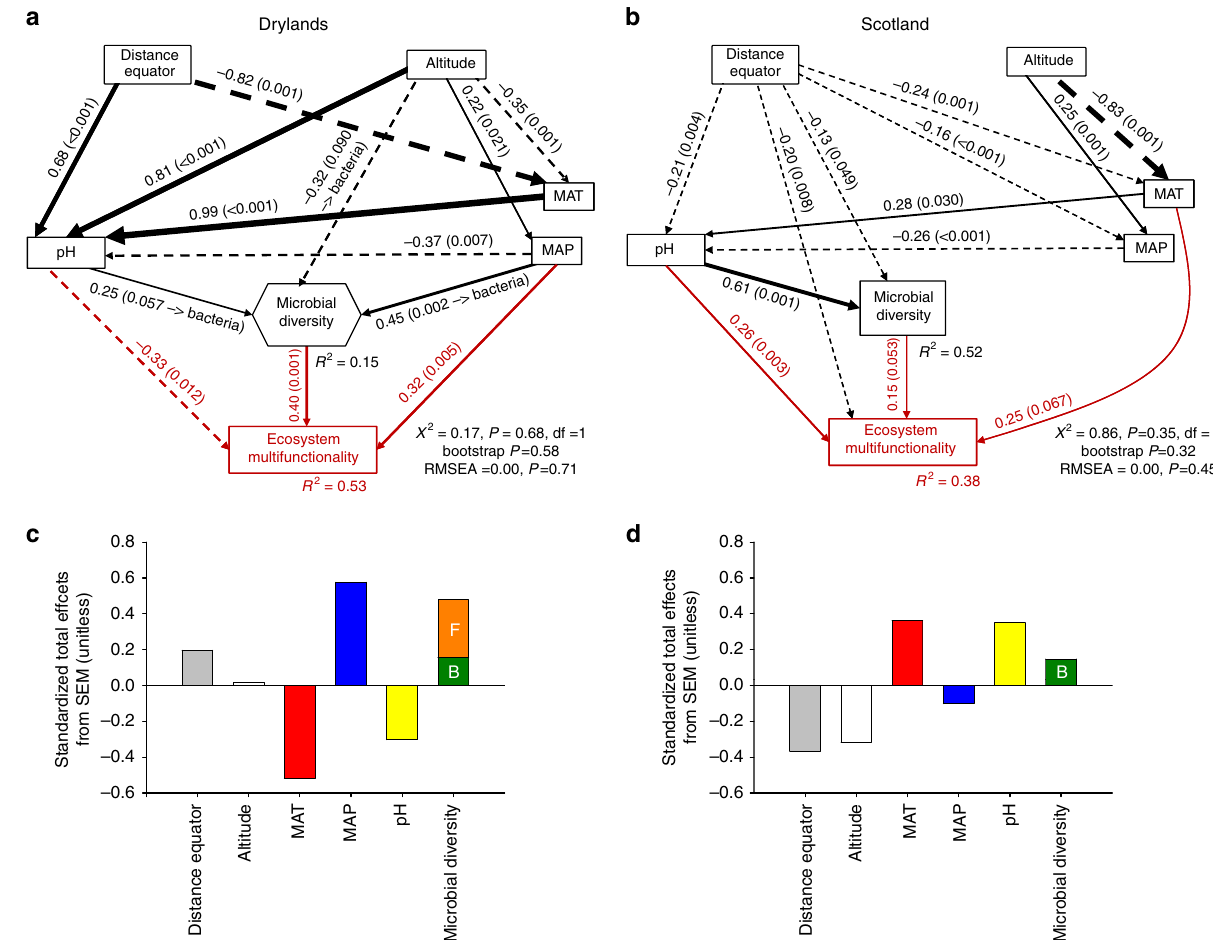
Figure 3 | Direct and indirect effects of space, climate, soil pH and microbial diversity on ecosystem multifunctionality. Structural equation models are shown for the Drylands ( a , c ) and Scotland ( b , d ) data sets. Numbers adjacent to arrows are indicative of the effect-size (bootstrap P value) of the relationship. Continuous and dashed arrows indicate positive and negative relationships, respectively. Spatial effects have no þ / (cid:2) sign. The width of arrows is proportional to the strength of path coefficients. R 2 denotes the proportion of variance explained. ( c , d ) Standardized total effects (direct plus indirect effects) derived from the structural equation models depicted above. Capital letters B and F within standardized total effects bars indicate the effects of bacterial and fungal diversity, respectively, in the Drylands data set. MAT, mean annual temperature; MAP, mean annual precipitation.